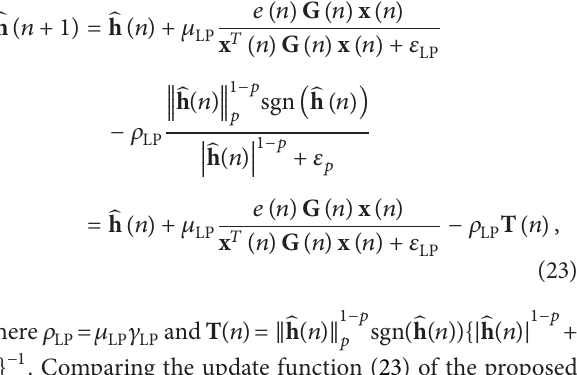
Figure 2: Typical sparse multipath